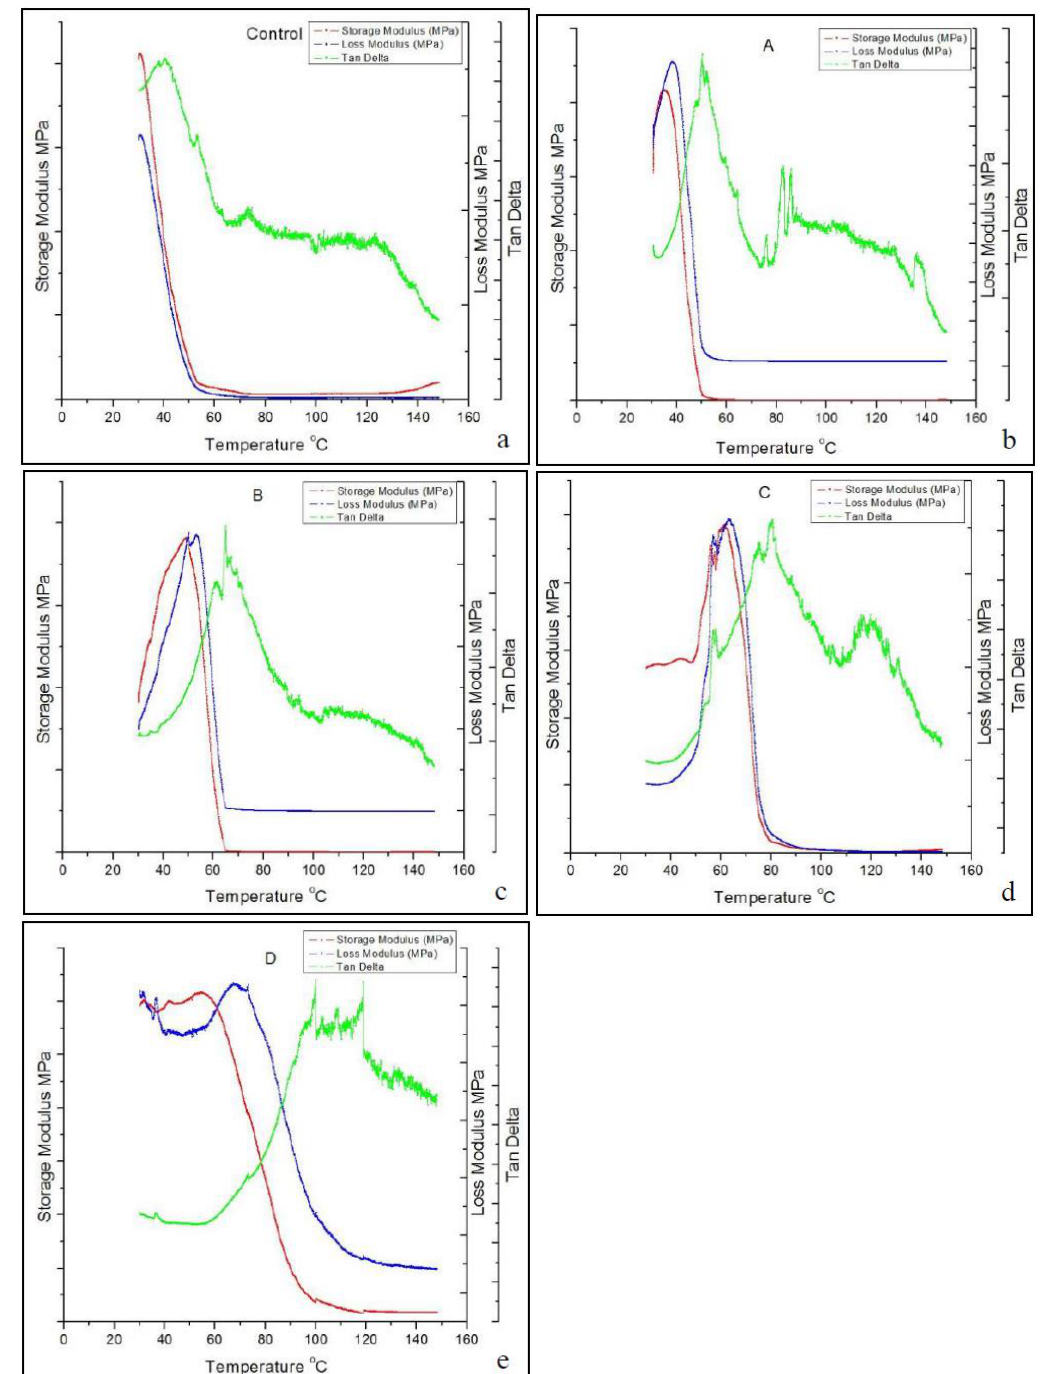
Figure 1 DMA curves of a) PUR control and b-e) CNF-PUF with 10-40% CNF replacement ratios Figure 6. DMA curves of ( a ) PUF control and ( b – e ) CNF-PUF with 10–40% CNF replacement